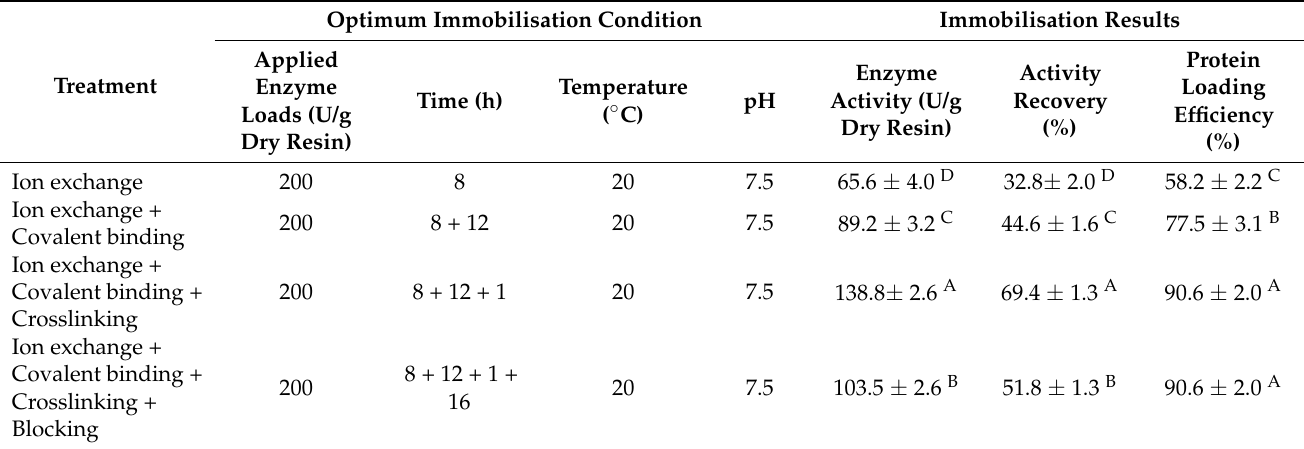
Table 1. Immobilisation of DPEase on HFA.